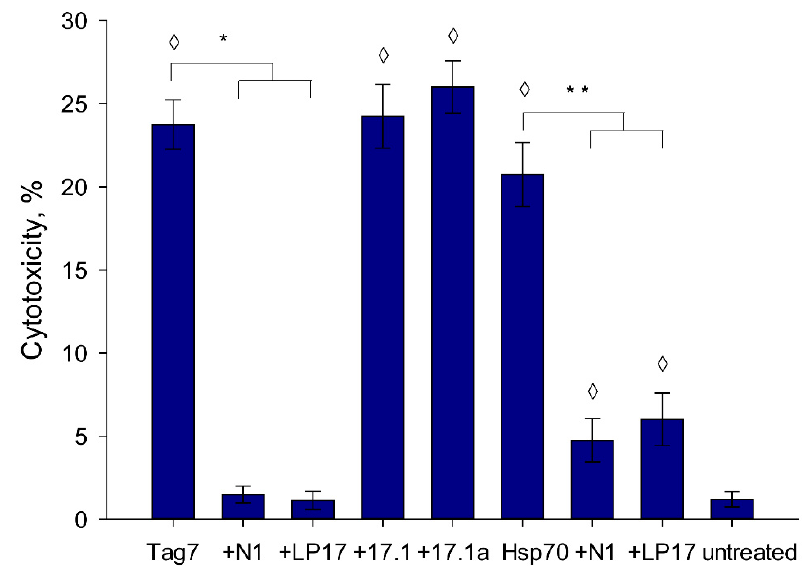
Figure 3. The cytotoxic activity of PBMC incubated with Tag7 or Hsp70 for six days in presence of N1, 17.1, 17.1A and LP17 peptides. Peptides were added to PBMC 30 min prior to activation. The cytotoxic activity of lymphocytes was measured against K562 cells (one-way ANOVA, p -value ◊ < 0.05 vs. untreated; one-way ANOVA, p -value: ** < 0.05, * < 0.01).